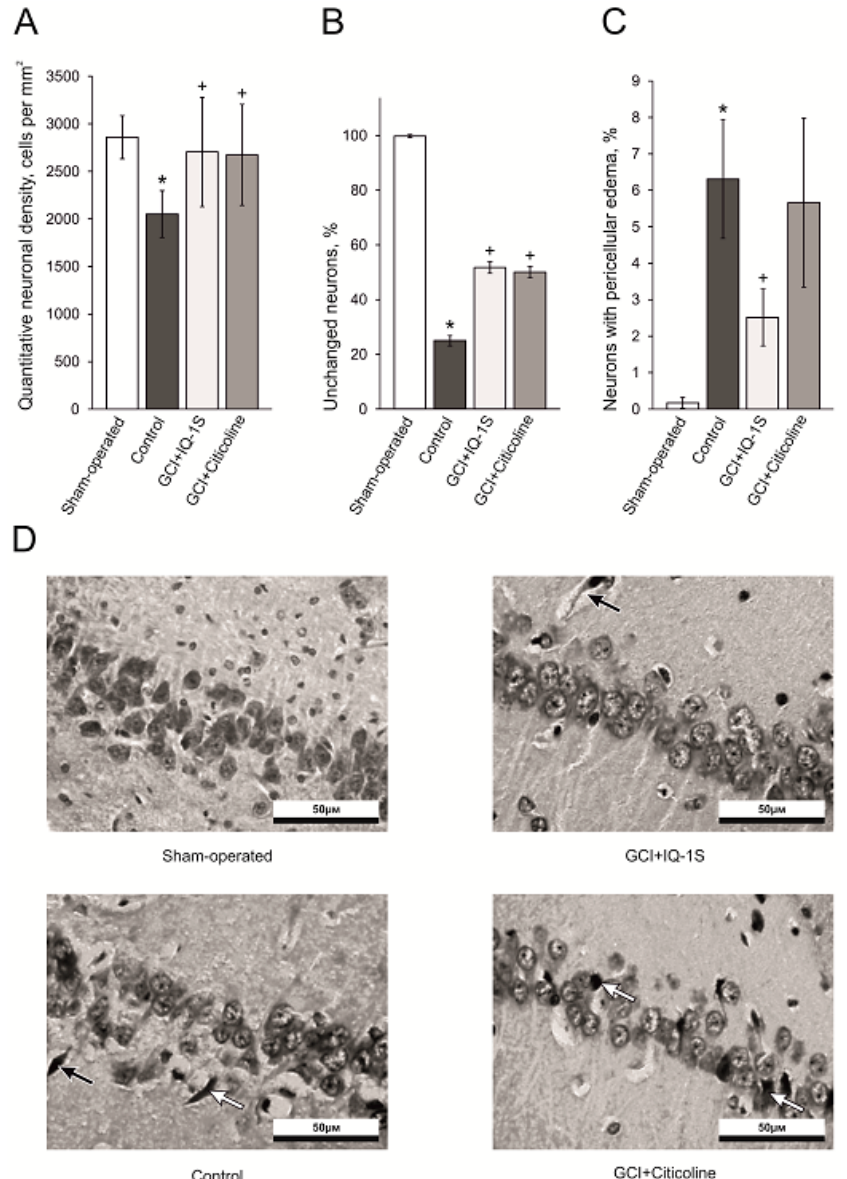
Figure 2. Effects of IQ-1S (50 mg/kg, i.g.) and citicoline (500 mg/kg, i.p.) on the quantitative neuronal density ( A ), percentage of unchanged neurons ( B ), percentage of neurons with pericellular edema ( C ) and illustrations of CA1-zone of hippocampus ( D ) in rats at day 5 after GCI. * p < 0.05 as compared with the sham-operated animals; + p < 0.05 as compared with the control. Black arrows indicate neurons with pericellular edema; white arrows indicate pyknotic eosinophilic neurons.